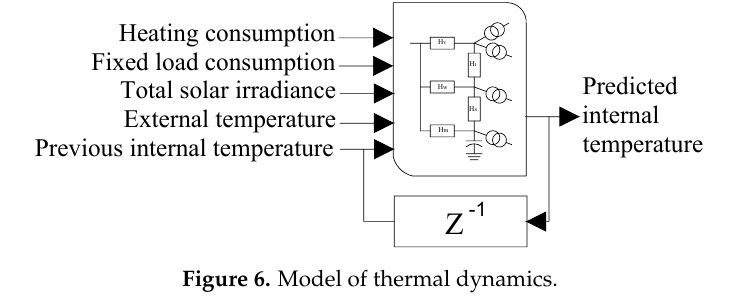
Figure 6. Model of thermal